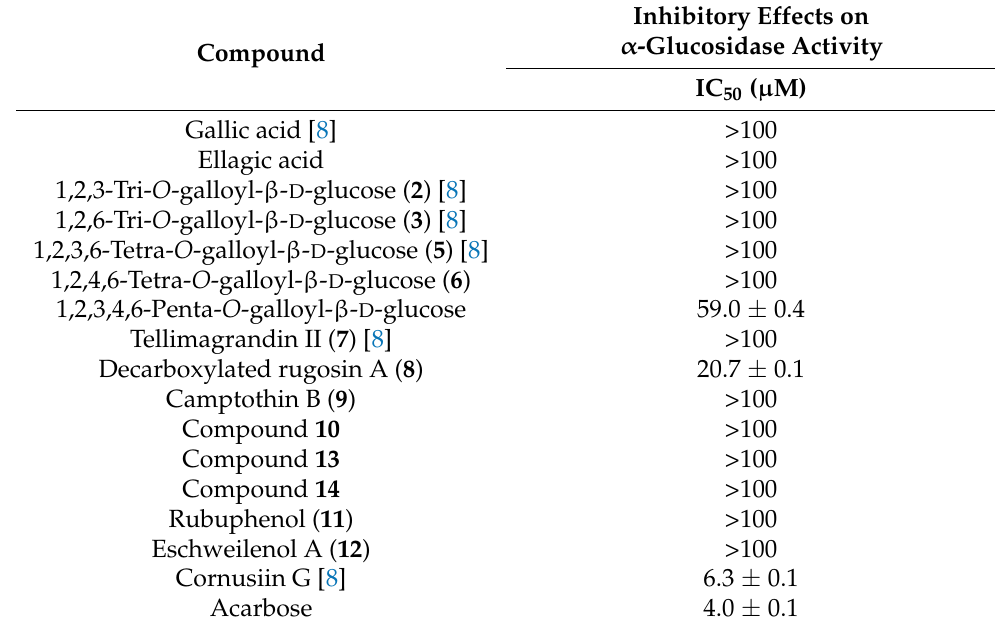
Table 1. α -Glucosidase inhibitory activity of polyphenols isolated from TBE and related compounds. Inhibitory Effects Compound